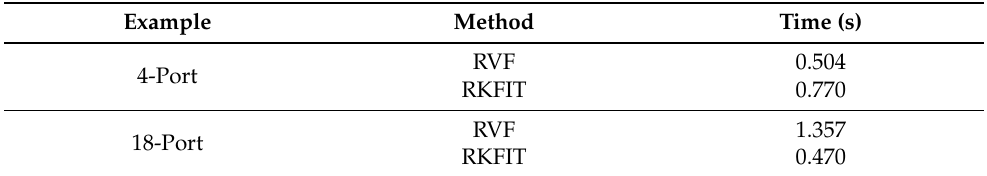
Table 1. Average time per iteration for Sections 3.1 and